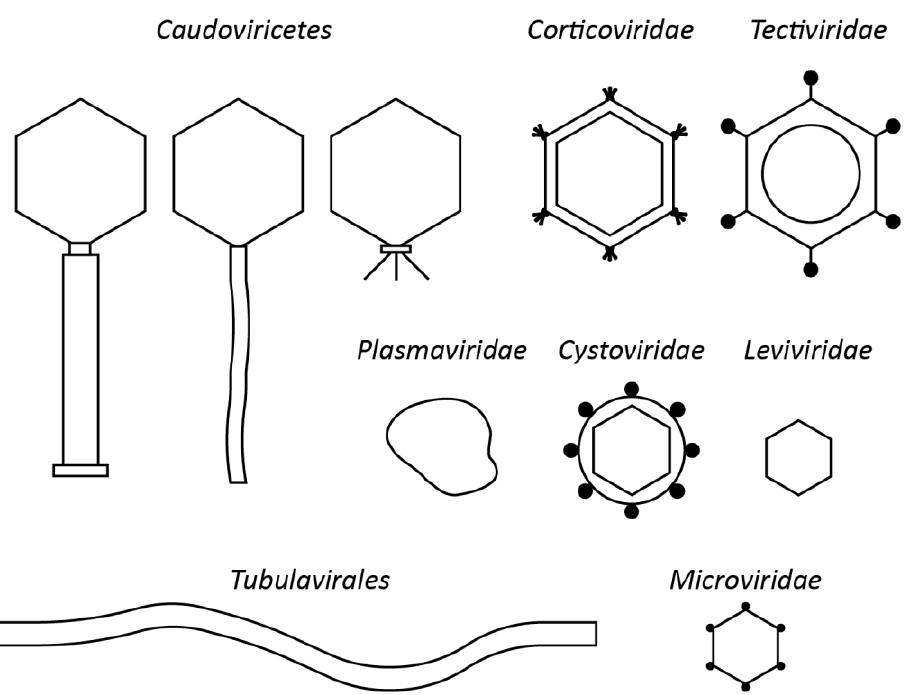
Figure 1. Line drawing of bacteriophage morphotypes, adapted from Ackermann, 2005 [6].